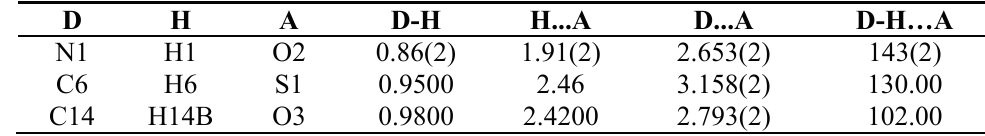
Table 3. Hydrogen bonding data for compound 2